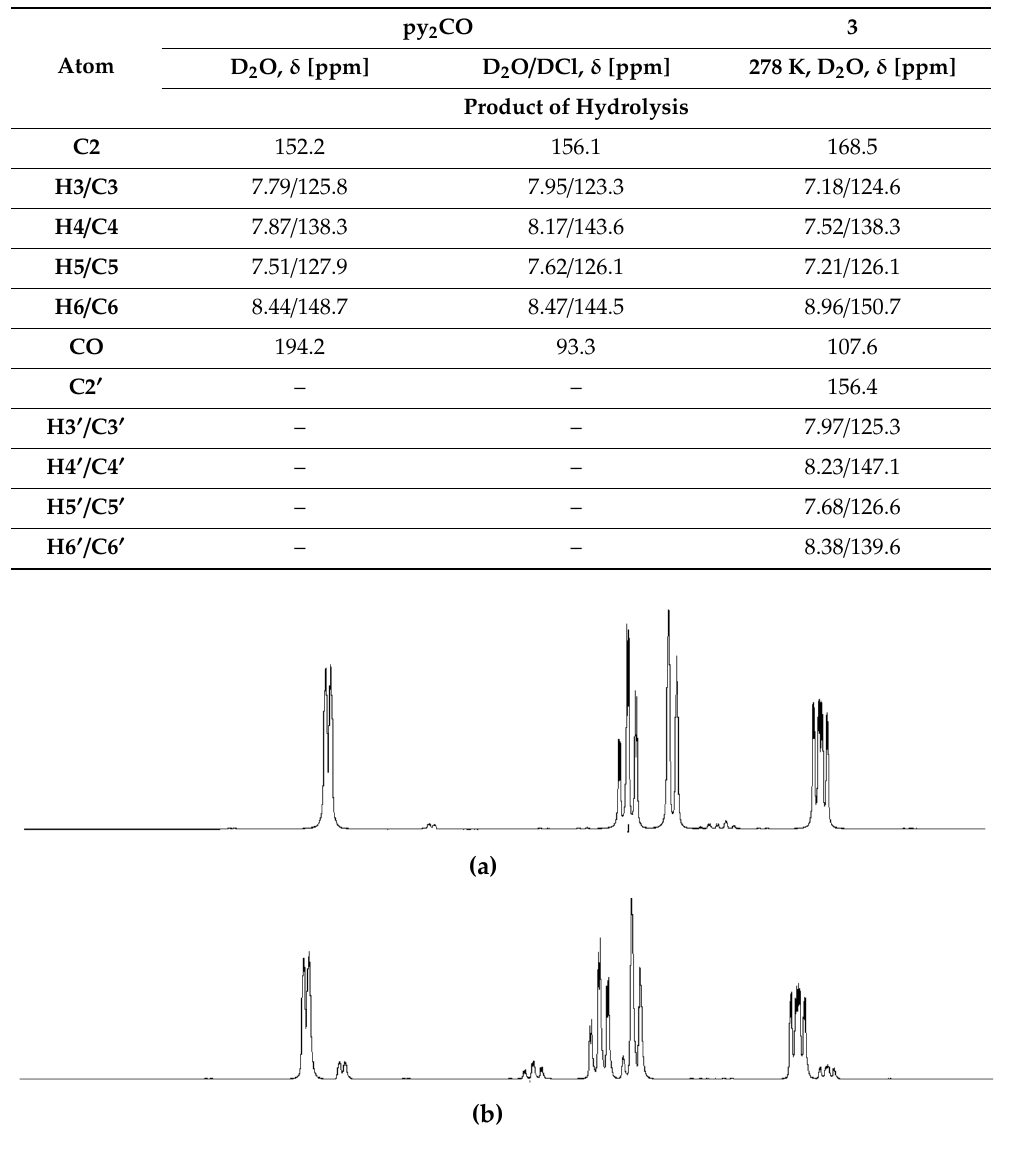
Table 6. 1 H, 13 C NMR chemical shifts of ligand (py 2 CO) and complex 3 in D 2 O.